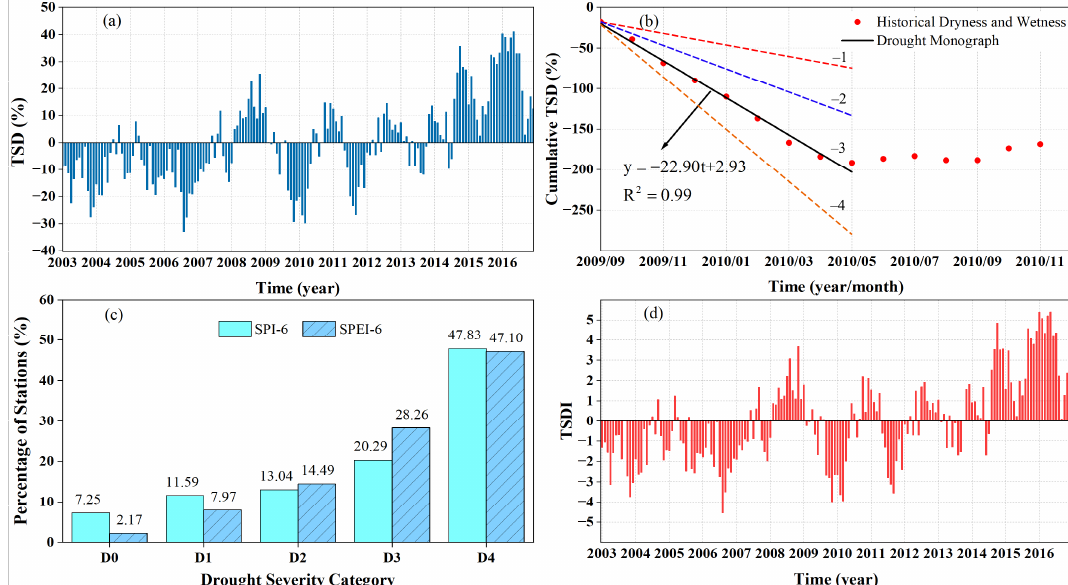
Figure 4. ( a ) The total storage deficit for Southwest China during 2003–2016; ( b ) Cumulative total storage deficit for Southwest China during 2003–2016; ( c ) The proportion of stations with different drought severity in Southwest China from September 2009 to April 2010; ( d ) TSDI in Southwest China from 2003 to 2016. Table 2. Statistics of TSDI-identified drought events.